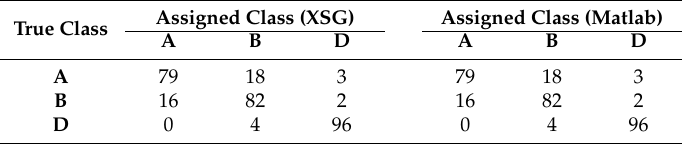
Table 3. Confusion matrix of XSG and Matlab based